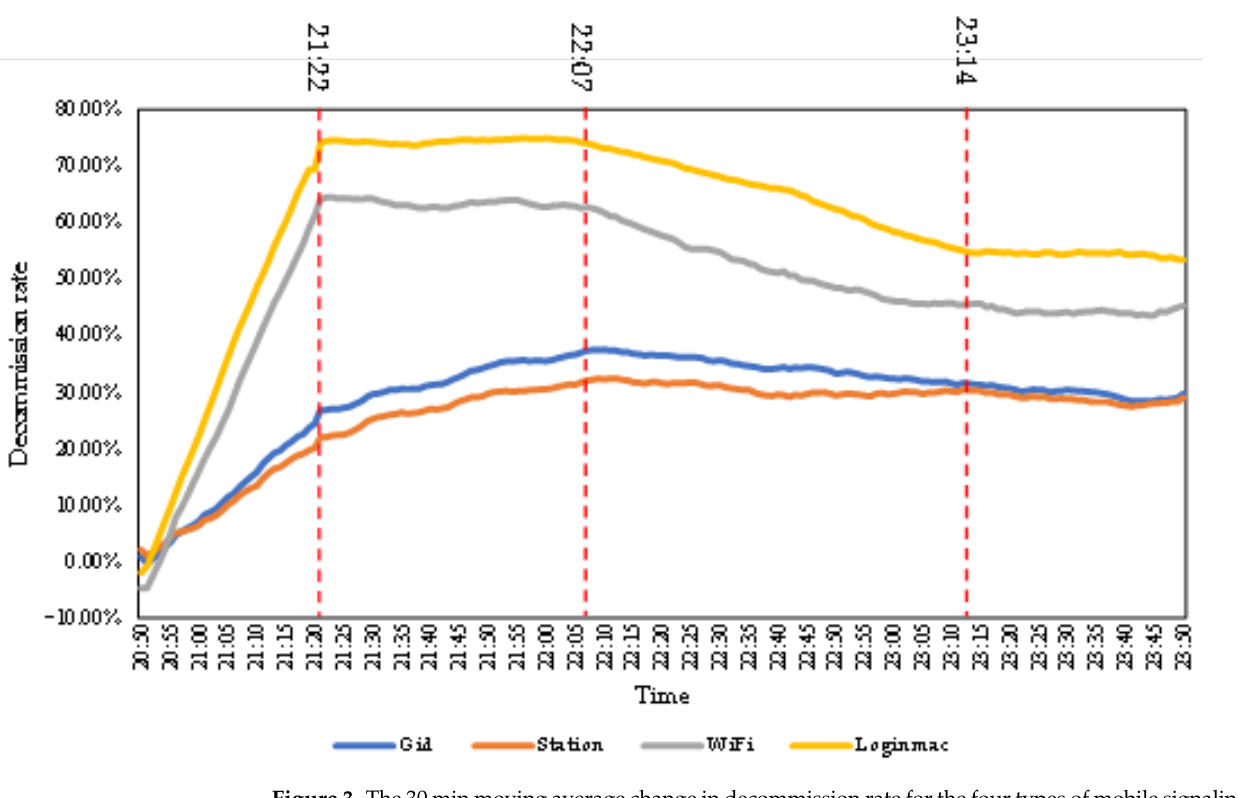
Figure 3. The 30 min moving average change in decommission rate for the four types of mobile signaling.